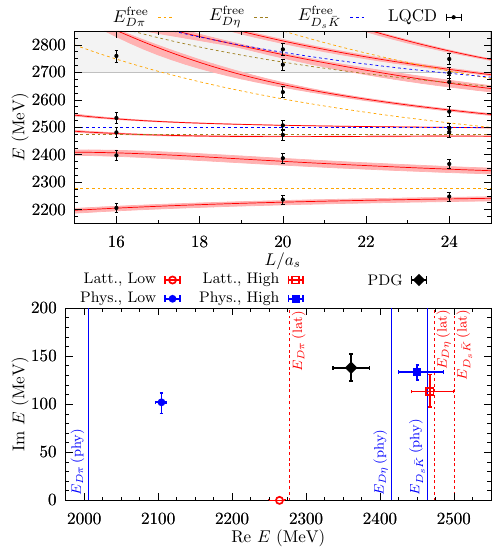
Figure 6. The upper panel shows the energy levels calculated in UCHPT with LECs determined in 2013 in comparison to the results of [26] in the ( S , I ) = (0 , 1 / 2) channel. Lower panel: Complex energy plane location of the two-pole-structure. Empty red (filled blue) symbols stand for the poles obtained when the LQCD [26] (physical) masses are used. The black diamond rep- resents the isospin average of the PDG values for D (cid:7) (2400) + . Figures from [33]. D (cid:7) 0